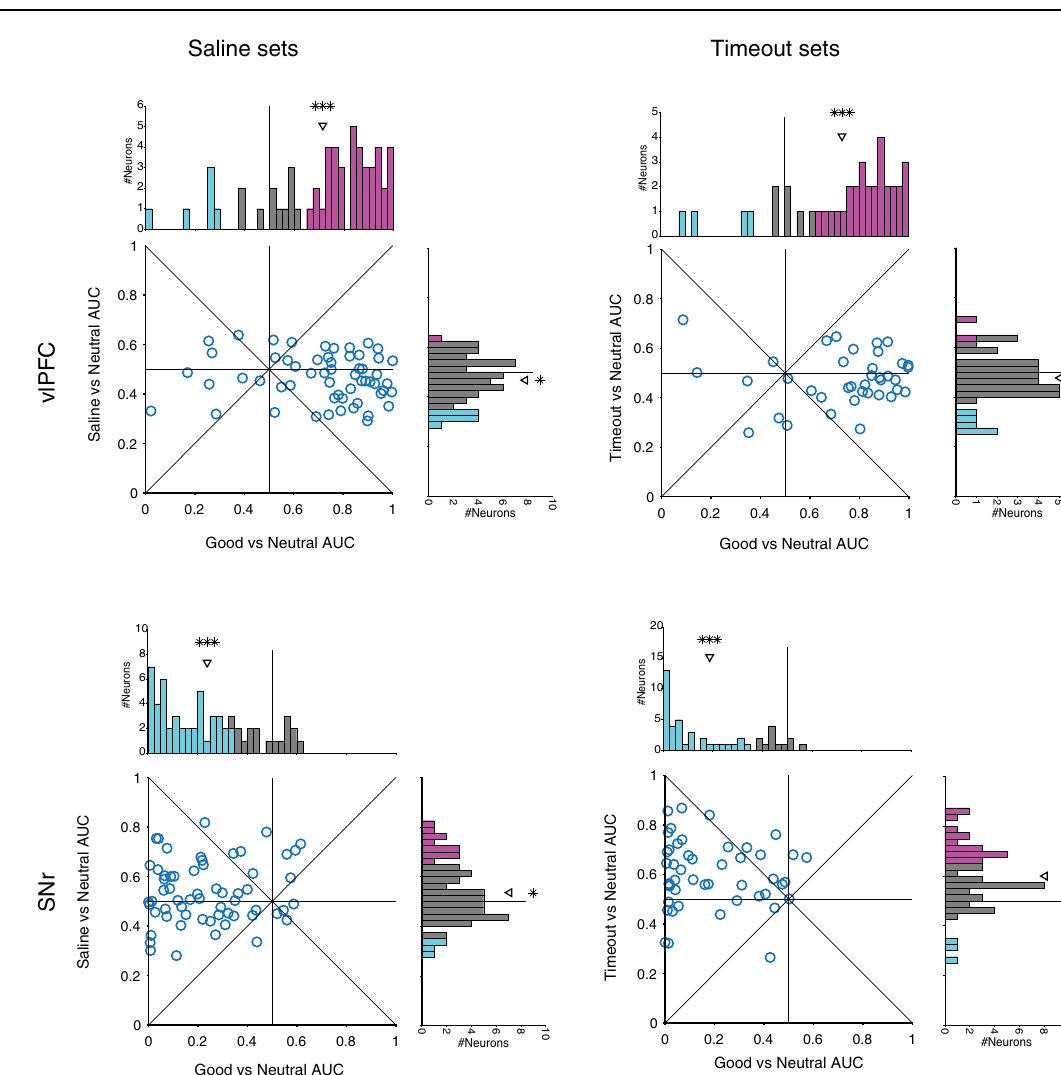
Pearson ’ s ρ =0.12, P =0.36,valueAUC=0.24 t 60 = − 11, P =5e-16,aversiveAUC=0.53 P =3e-2, Timeout set: vlPFC Pearson ’ s ρ =0.03, P =0.9, value AUC=0.73, t 60 =2.1, P =2e-7, aversive AUC=0.47 t − 1.5, P =0.14, cdlSNr: Pearson ’ s t 38 =6.3, 38 = − 11, P =9e-16, aversive AUC=0.59 t ρ = − 0.08, P =0.5, value AUC=0.18 t 47 = 47 =5.1, P =5e-6). Same format as Fig. 3. Source data are provided as a Source Data fi